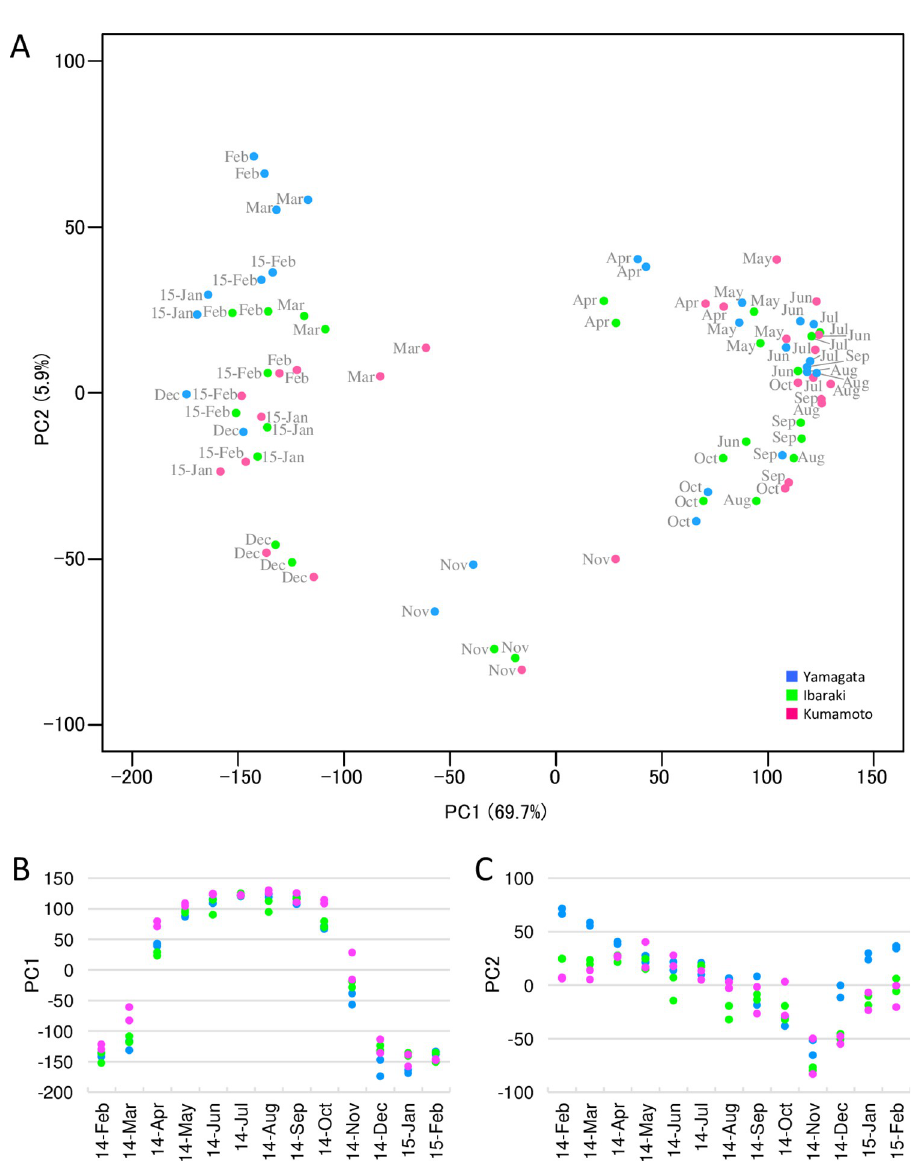
Fig 2. PCA of microarray data. (A) The first two principal components obtained from PCA of annual time series samples of microarray data are shown. The sample names ‘15-Jan’ and ‘15-Feb’ indicate samples collected in January and February 2015, respectively. (B) Relationship between sampling day and PC1 score. (C) Relationship between sampling day and PC2 score.